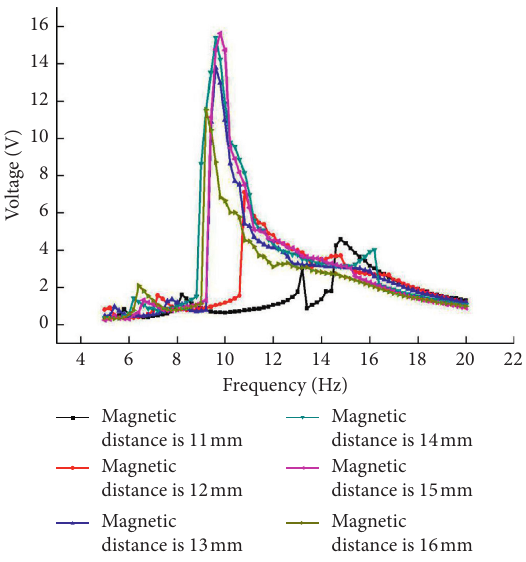
Figure 28: Relation of the voltage-frequency of the structure C is given when initial magnetic distances are selected as 11mm, 12mm, 13mm, 14mm, 15mm, and 16mm, respectively.